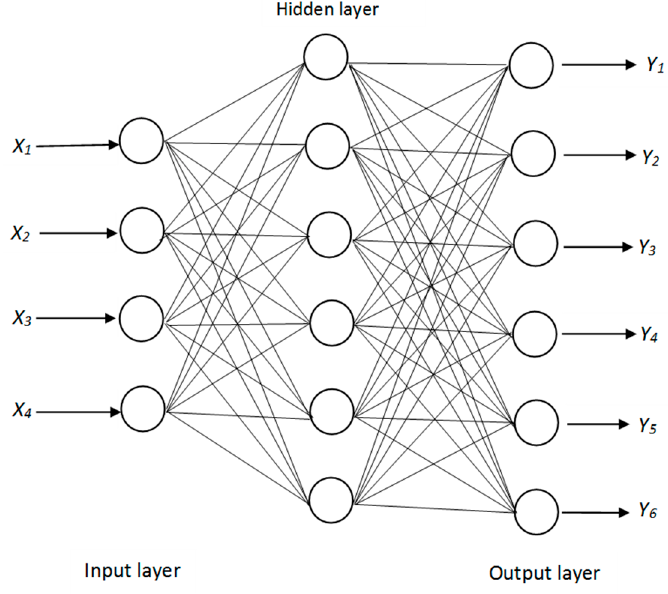
Figure 4. Schematic representation of the optimum 4-6-6 multi-layer perceptron artificial neural network.